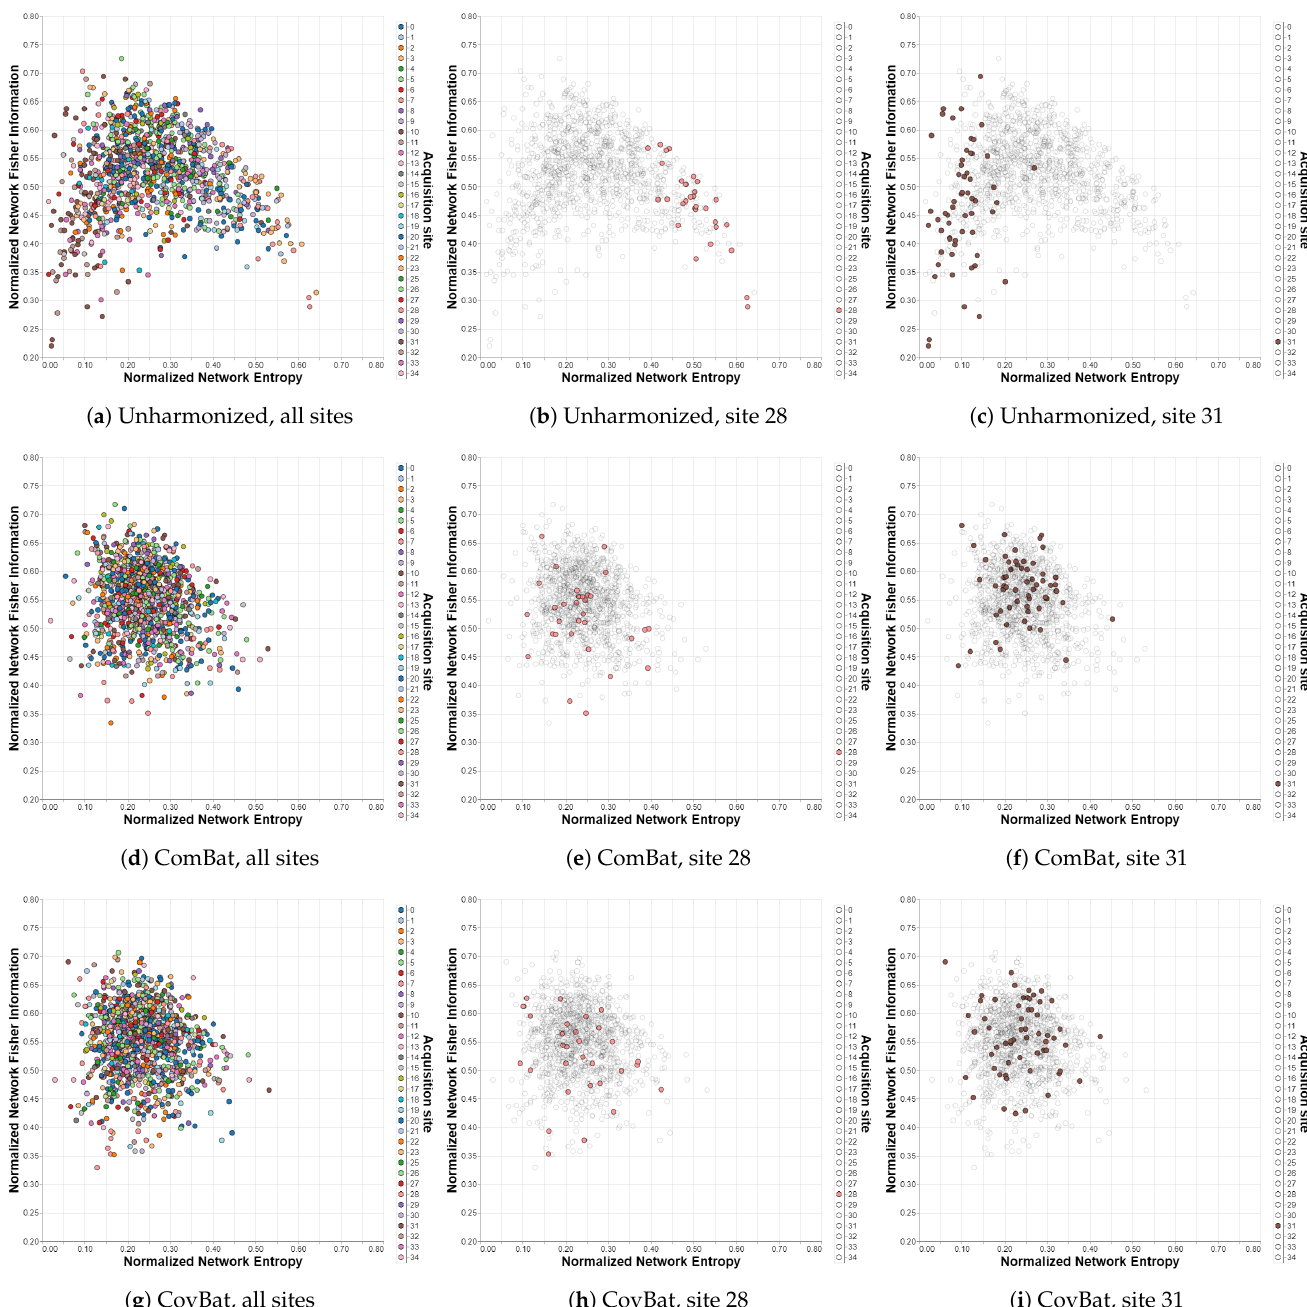
Figure 3. Shannon − Fisher planes for IMPAC/MSDL with different harmonization methods. Sites 28 and 31 are shown separately for each case to emphasize the impact of harmonization. Each point corresponds to a different subject in the dataset and each color to a different acquisition